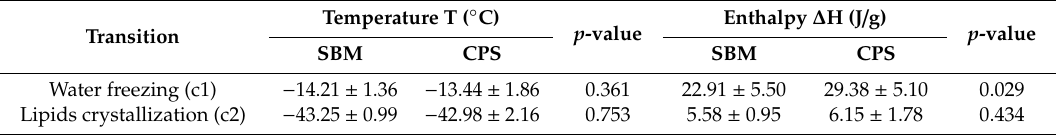
Figure 1. Differential scanning calorimetry (DSC) cooling thermograms of subcutaneous fat samples from broiler chickens fed soybean meal (SBM) and chickpea seeds (CPS). Exothermal processes are directed up. Table 2. DSC freezing parameters of subcutaneous fat of broiler chickens fed soybean meal and chickpea seeds.